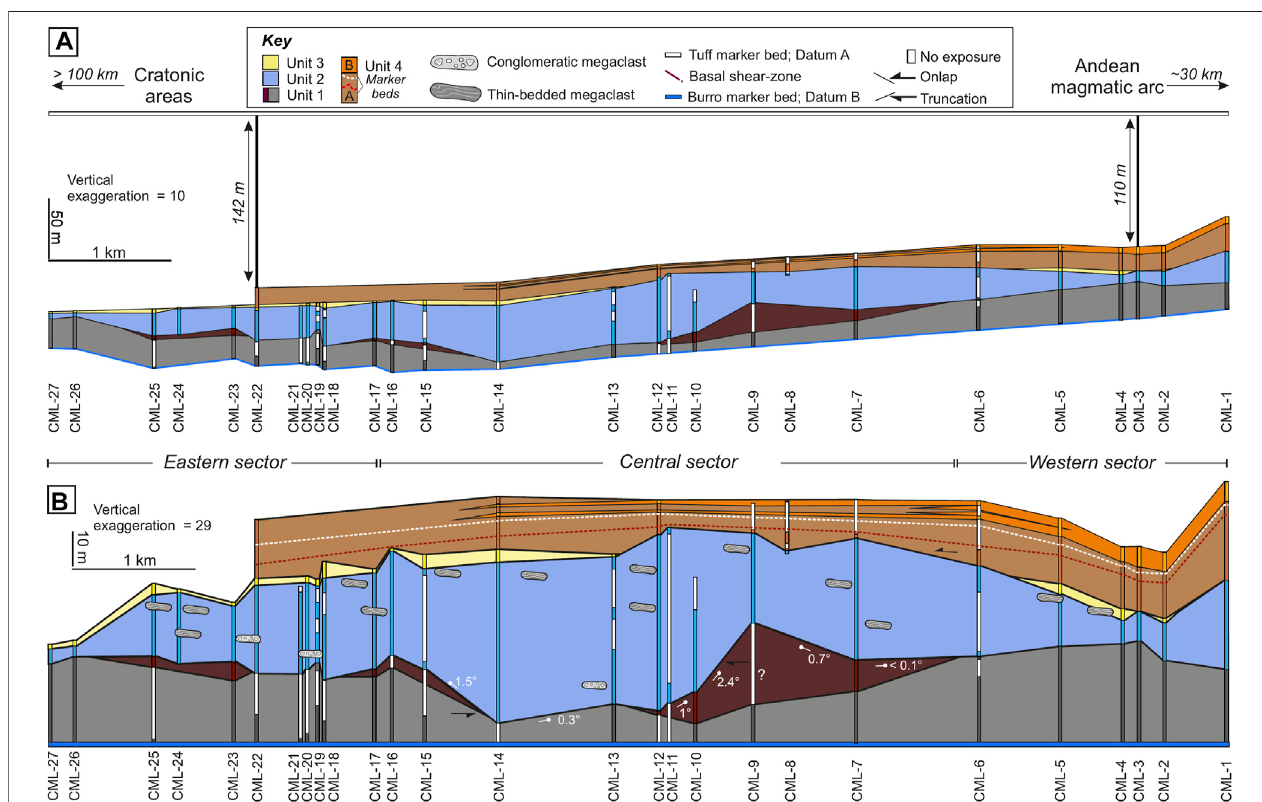
FIGURE 3 | Correlation panels showing the spatial relationship between stratigraphic units in the Bathonian succession of the Los Molles Formation and the different depositional architectures constrained by fl attening on the top and basal datums. (A) Correlation panel including Units 1 to 4 with the Tuff marker as a datum (Datum B) showing the step-like geometry of the slope. (B) Correlation panel with the basal Burro marker bed (Datum A) as a datum showing the complex ramp- fl at geometry and the basal-shear zone elements (brown coloured zone) at the base of Unit 2 and the correlation within Unit 4A based on two continuous sandstone marker beds. Note the heterogeneous distribution of Unit 3 and the pinching of Unit 4B in the central sector.